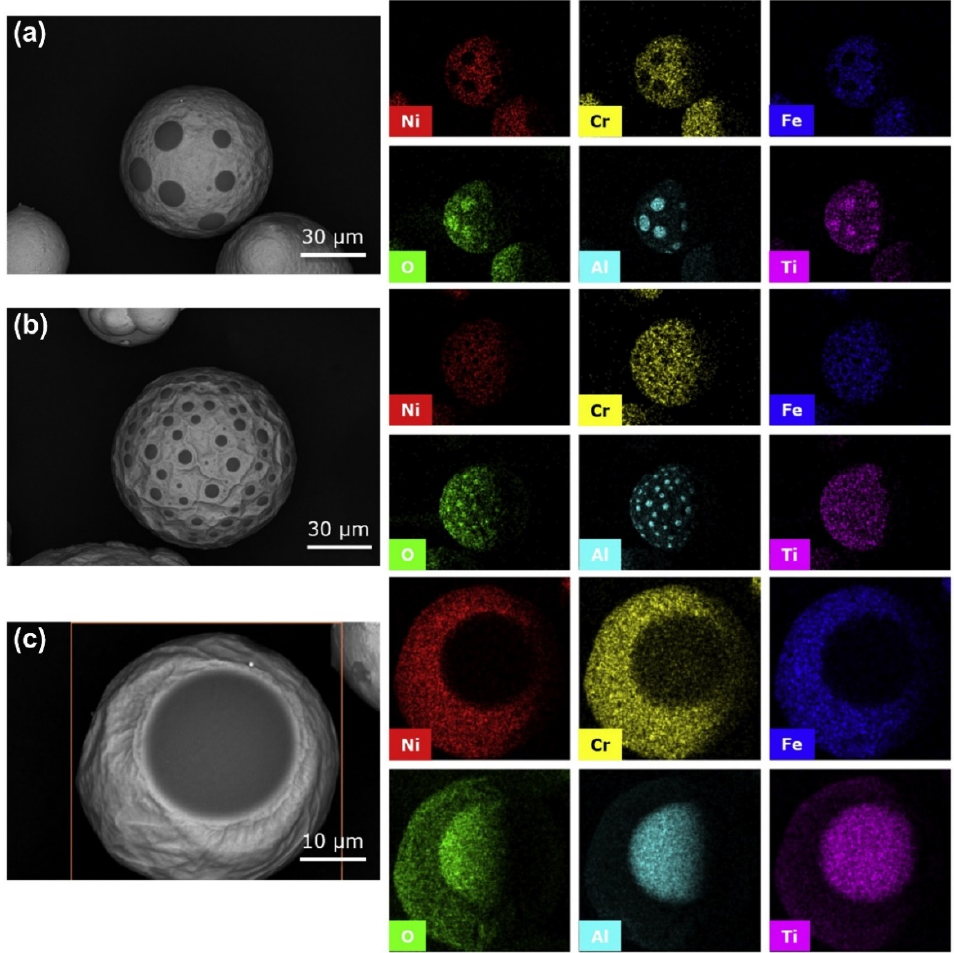
Figure 17. Back-scattered electron micrograph, and electron X-ray dispersive spectroscopy mapping of elements of Inconel 718 spatter collected from the ReaLizer SLM50. ( a – c ) shows that the dark spots mostly contain Al and O, and that the larger dark spots also contain Ti. EDS quantification results indicated that the oxides were a combination of Al 2 O 3 and TiO 2 . (Reprinted with permission from Ref. [66]. Copyright 2018 Elsevier B.V.).